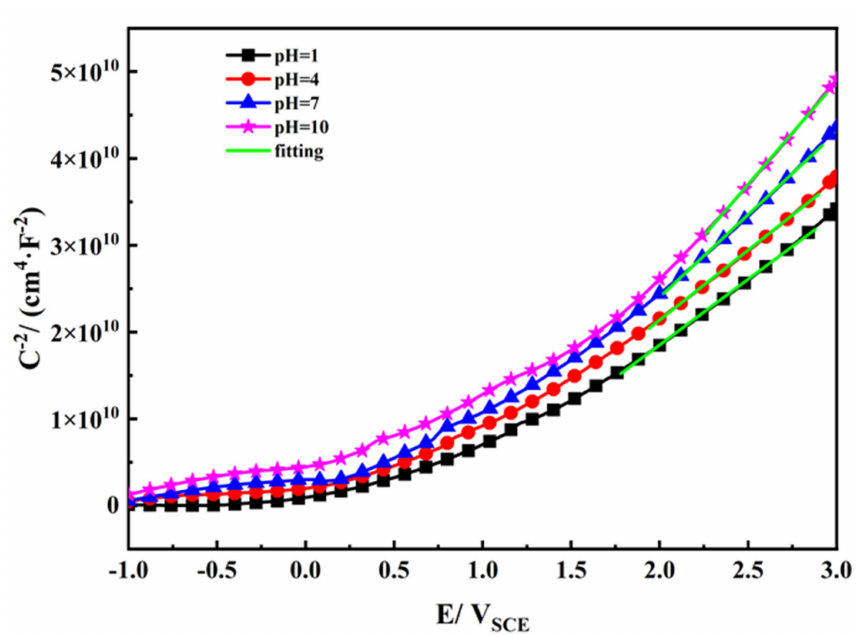
Figure 5. Mott–Schottky plots of TA2 in simulated seawater with different